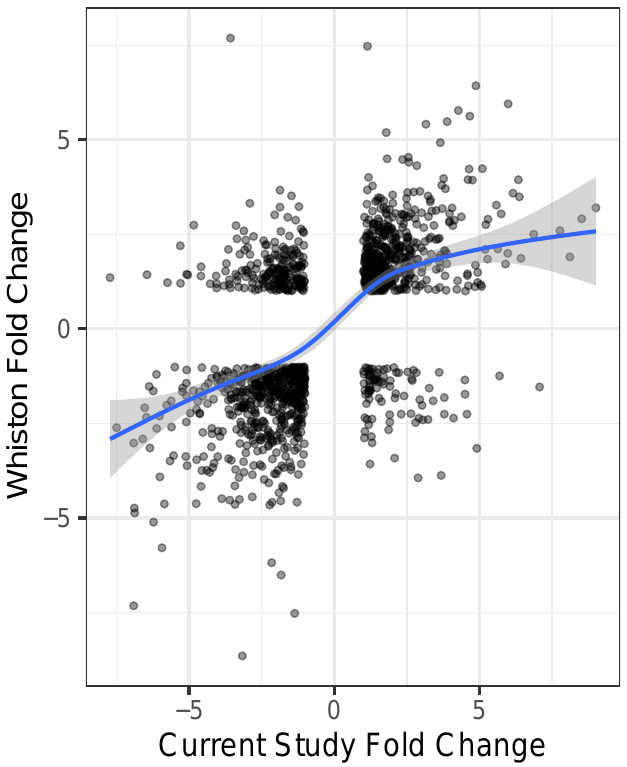
Figure 4. Comparison of FC values in this study to a previous study by Whiston et al. Legend: Genes with log 2 FC values (young spherules/mycelia) > 2 or < –2 in the current study were selected. FC values of genes in the current study are shown on the X axis and the FC values of matched genes from Whiston study [7] are shown on the Y axis. The regression line was derived from the linear model and the shaded area indicates the 95% confidence limits. The plot was made with ggplot2 R package and the regression line was drawn with the geom smooth option.